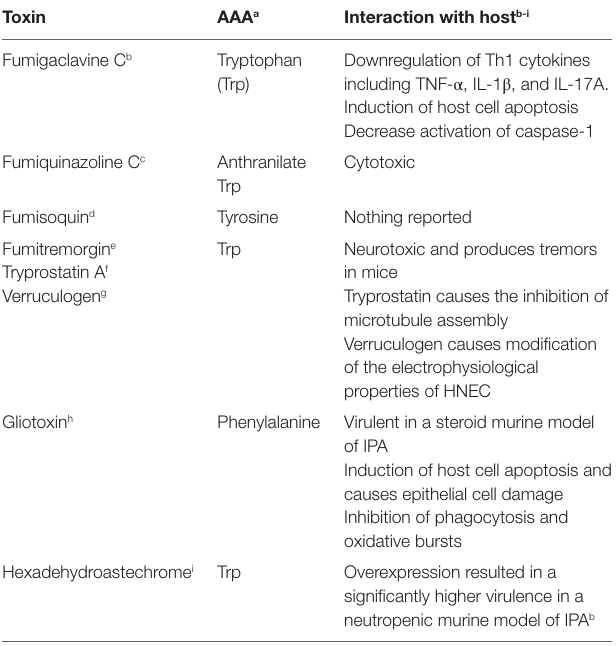
TAble 1 | Aspergillus fumigatus non-ribosomal peptides containing aromatic amino acids (AAAs) in their peptide structure.